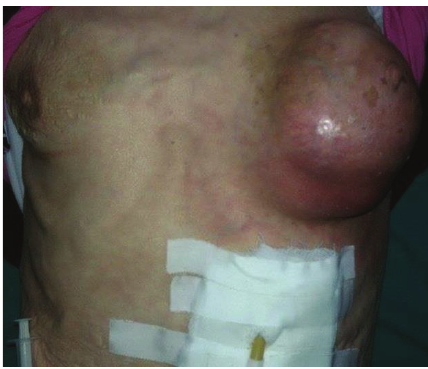
Figure 1: Left breast mass with gastrostomy.